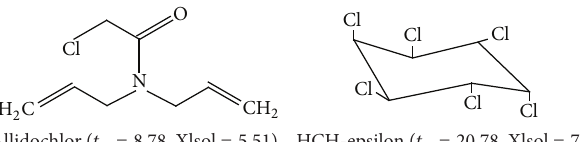
F 1: Comparison of